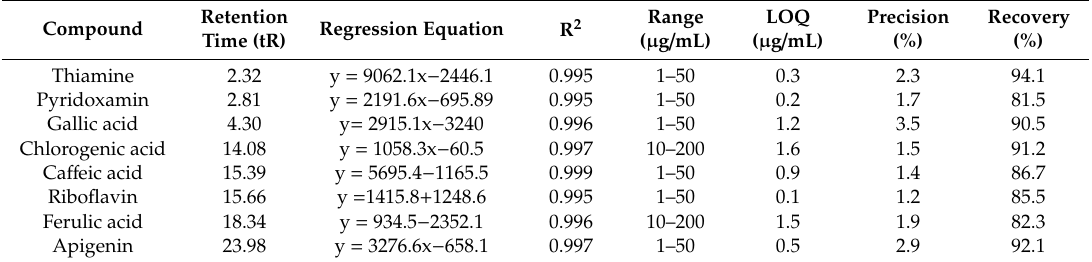
Figure 2. Mass spectrometry (MS) spectra of the extract of E. formosanus . ( a ) Thiamine, ( b ) pyridoxamin, ( c ) gallic acid, ( d ) chlorogenic acid, ( e ) caffeic acid, ( f ) riboflavin, ( g ) ferulic acid and ( h ) apigenin. Table 2. Linear regression equations, coefficients (R 2 ), linear range, precisions, recovery yields and limit of quantification (LOQ) of eight signature compounds.